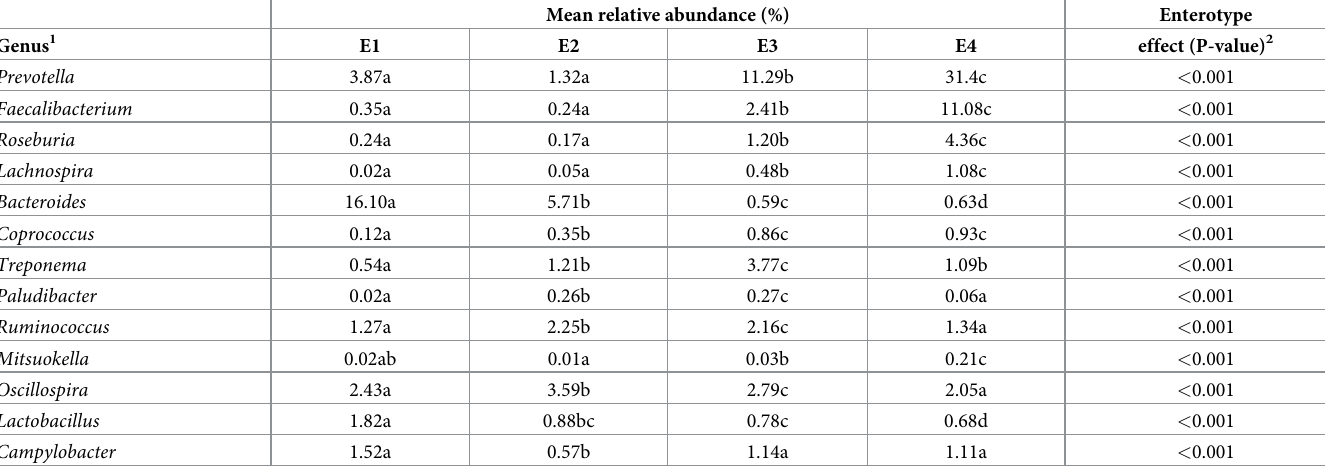
Table 3. Relative abundance of genera discriminating the E1, E2, E3, and E4 enterotypes.